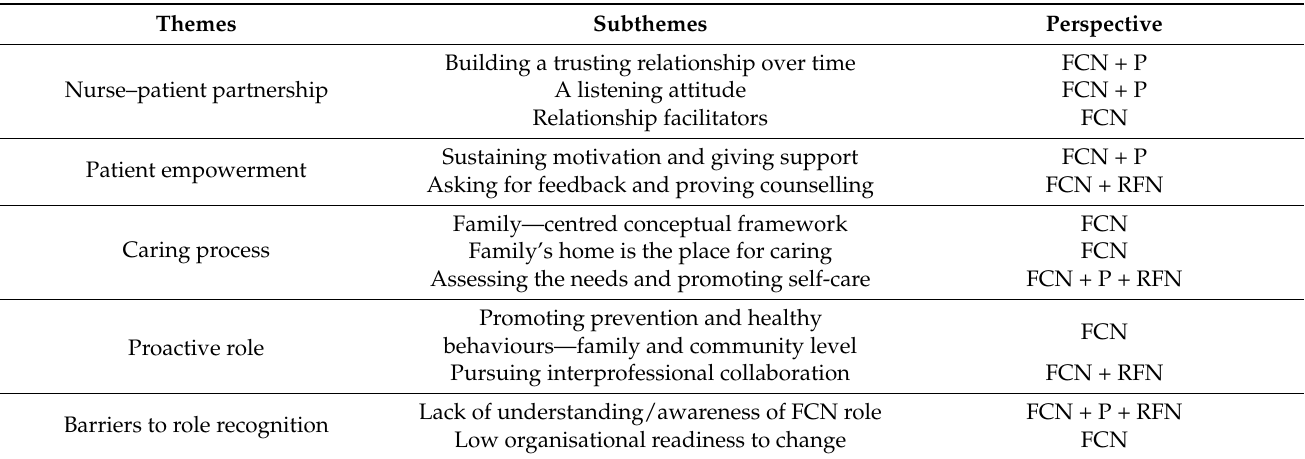
Table 2. Themes and subthemes emerging from interviews and field